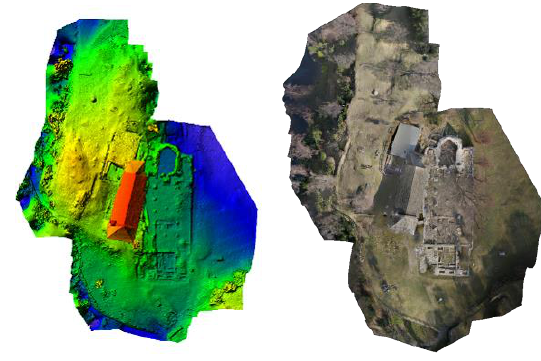
Fig. 8. DEM and RGB